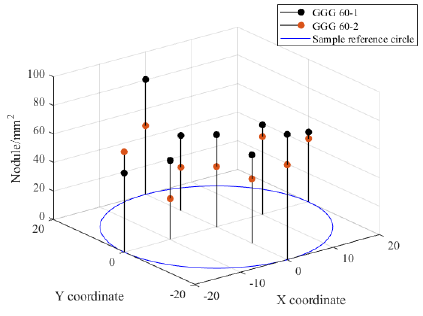
Figure 11. Nodule count in GGG60.